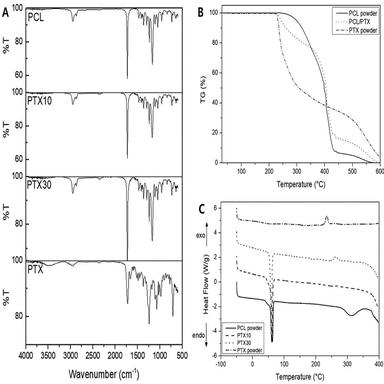
Chemical (A) and thermal (B, C) characterization analysis of PTX/PCL scaffolds with different drug concentrations.